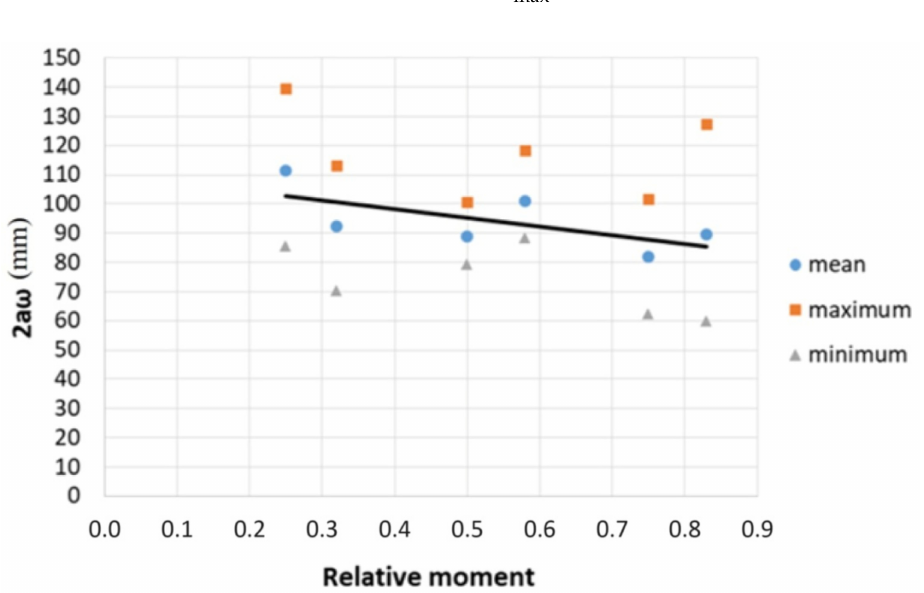
Figure 32. Section 2a ω by relative